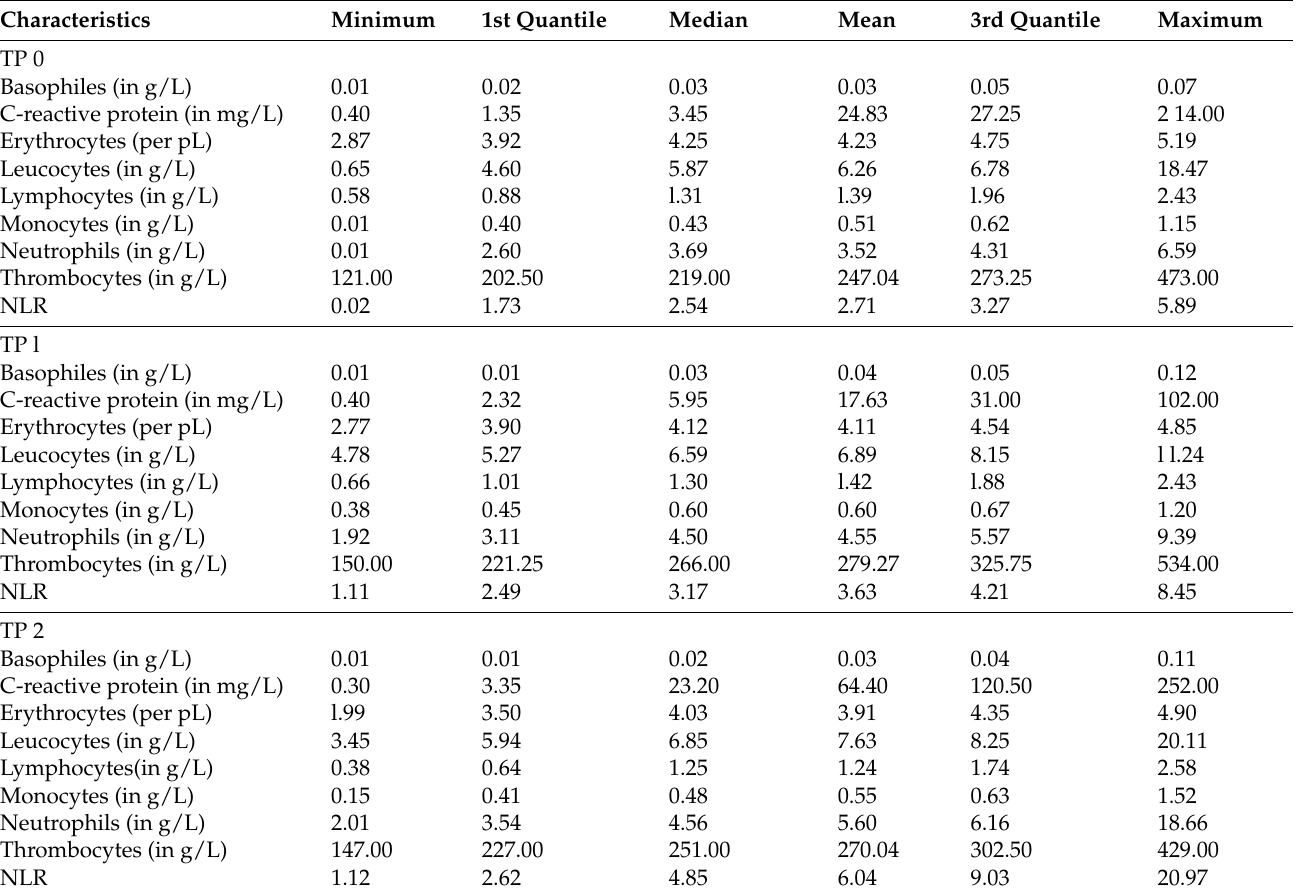
Table 3. Descriptive statistics of blood parameters in patients with progressive disease after